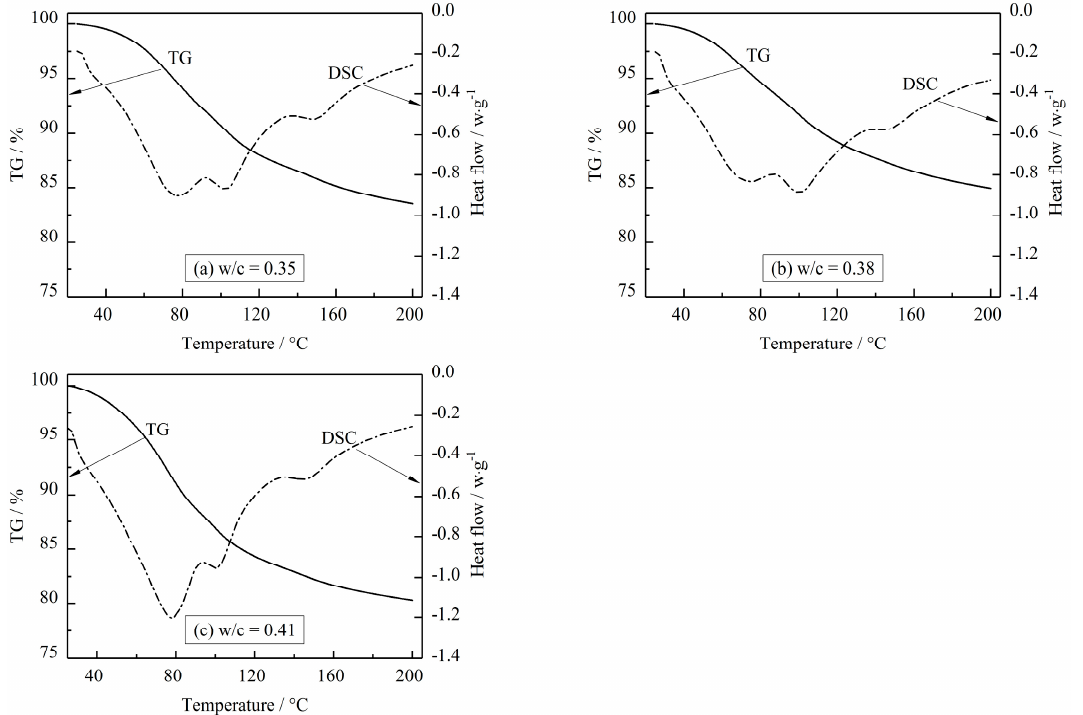
Figure 7. TGA / DSC curve of hardened cement Figure 7. TGA/DSC curve of hardened cement paste.